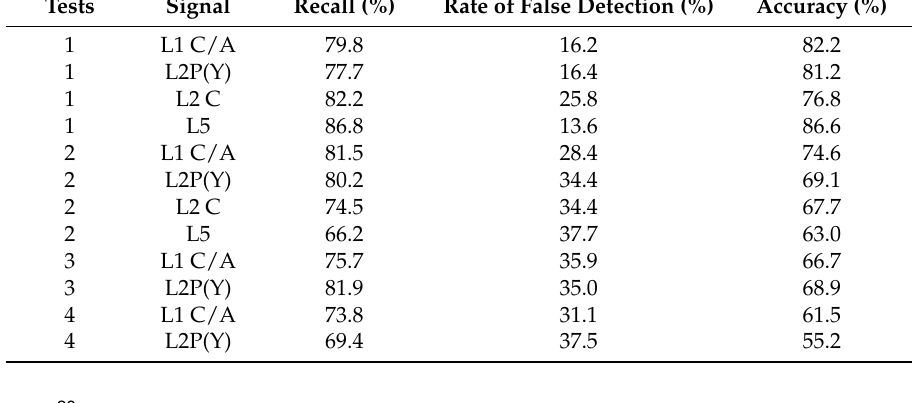
Table 9. Results of Tests 1, 2, 3, and 4.